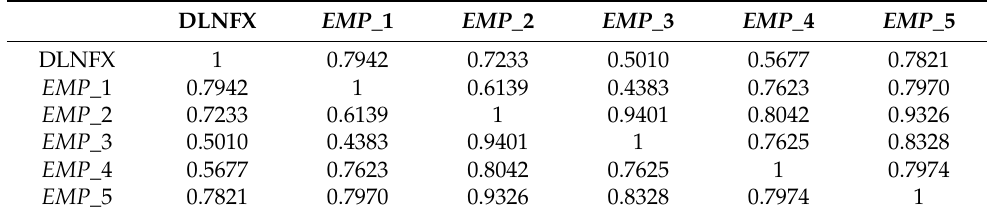
Table A2. Correlation results for Ghana.